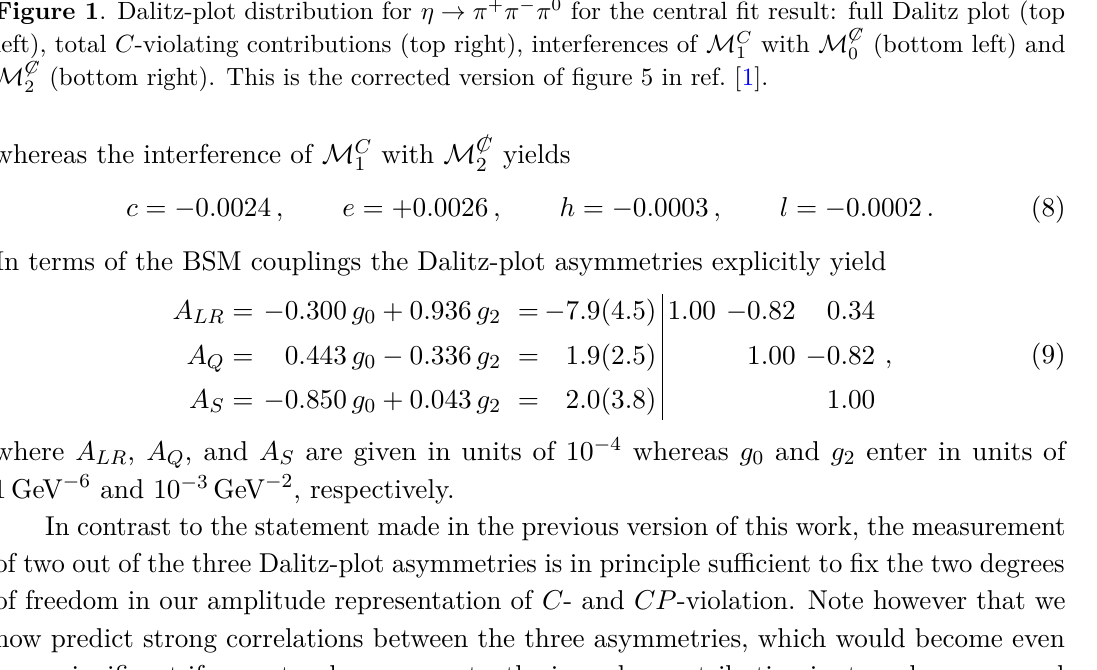
π + π − π 0 for the central fit result: full Dalitz plot (top →